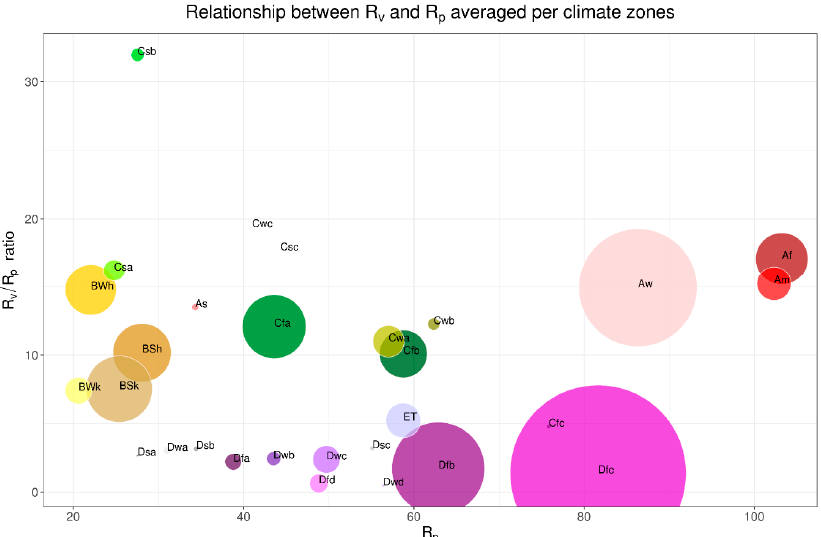
Figure 4. Ratios of vegetation primary production and green water resource resilience indicators ( R P and R V , respectively) vs R P averaged over the homogeneous KG climate zones displayed in Figure 3d.